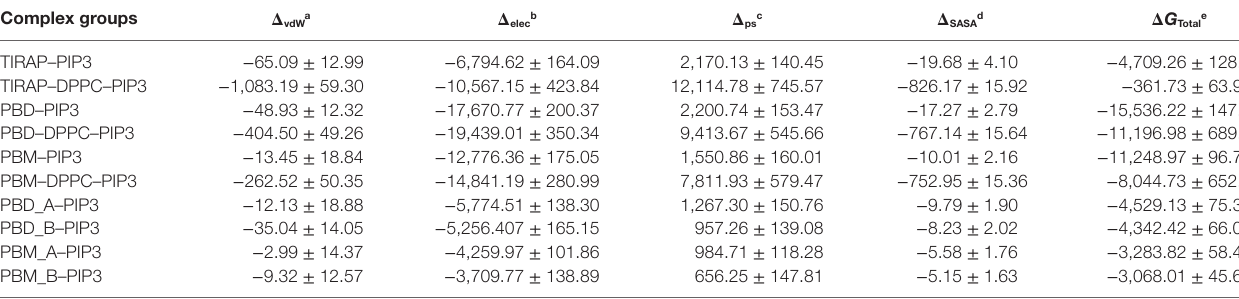
TaBle 4 | Binding free energy (kJ mol − 1 ) between PIP3 and important segments of TIRAP. complex